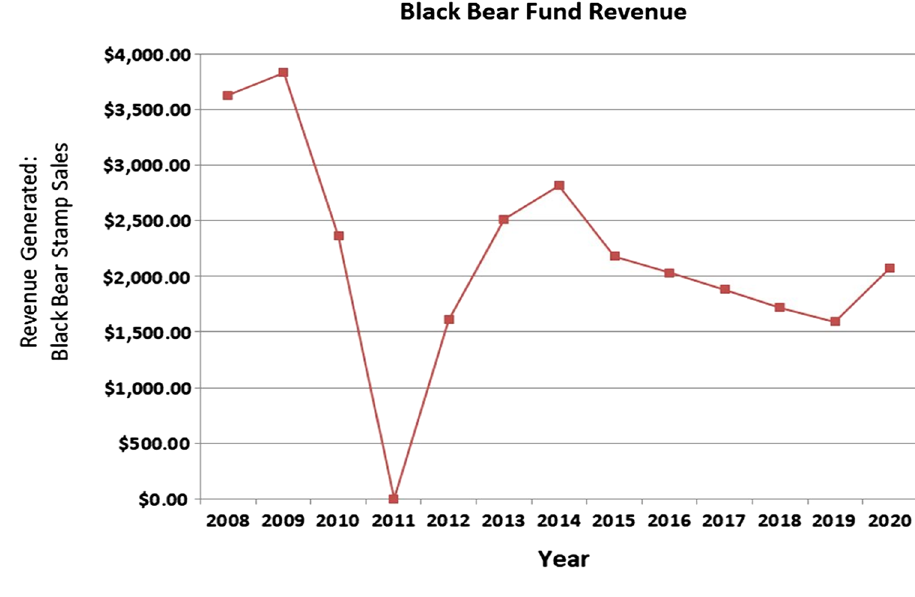
Fig. 4 Annual amount earned from sales of the Maryland Black Bear Reimbursement stamps through the Mary- land Department of Natural Resources to reimburse farm- ers for crop damage by Black Bears